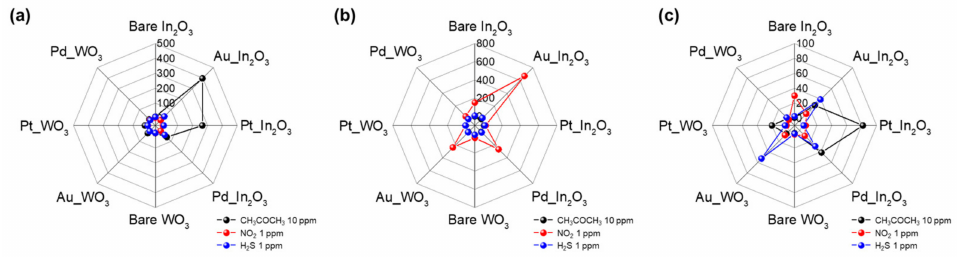
Figure 7. Polar plot of 2 × 4 array sensor responses of ( a ) 10 ppm CH 3 COCH 3 , ( b ) 1 ppm NO 2 , and ( c ) 1 ppm H 2 S at the operating temperatures of 300, 150, and 250 ◦